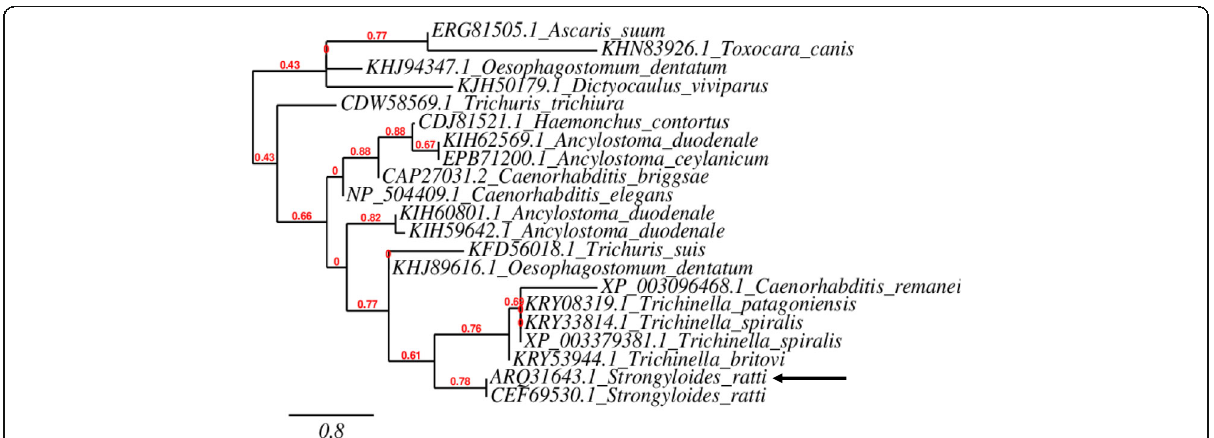
Fig. 5 Phylogenetic tree of 21 TIL orthologs from nematodes resulted from DELTA-BLAST (Domain Enhanced Lookup Time Accelerated BLAST) of the deduced Sra-TIL protein sequence, using Phylogeny.fr program (http://www.phylogeny.fr/). Bootstrap support values are shown on the branches. The compared proteins are represented by GenBank accession number and the name of